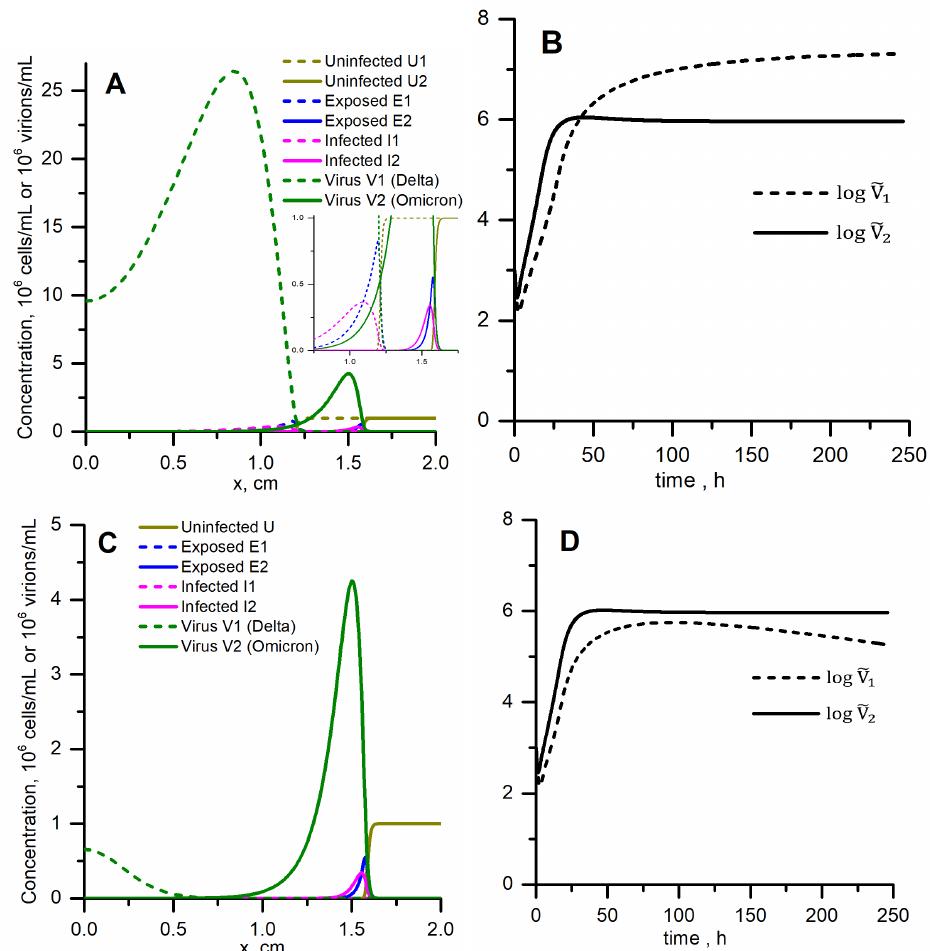
Figure 5. Spatial replication and propagation of Delta (dashed lines) and Omicron (solid lines) variants without competition for cells ( A , B ) and with competition ( C , D ). ( A ) Two uncoupled models given by Equation (1) were solved simultaneously. ( C ) Equation (3) were solved. ( A , C ) Solutions corresponding to the same distance (1.5 mm) travelled by Omicron autowave V 2 ( x ) are shown. ( B , D ) Logarithms of integrated virus concentrations vs. time are shown. ρ = 1, all other parameters are listed in Table 1.